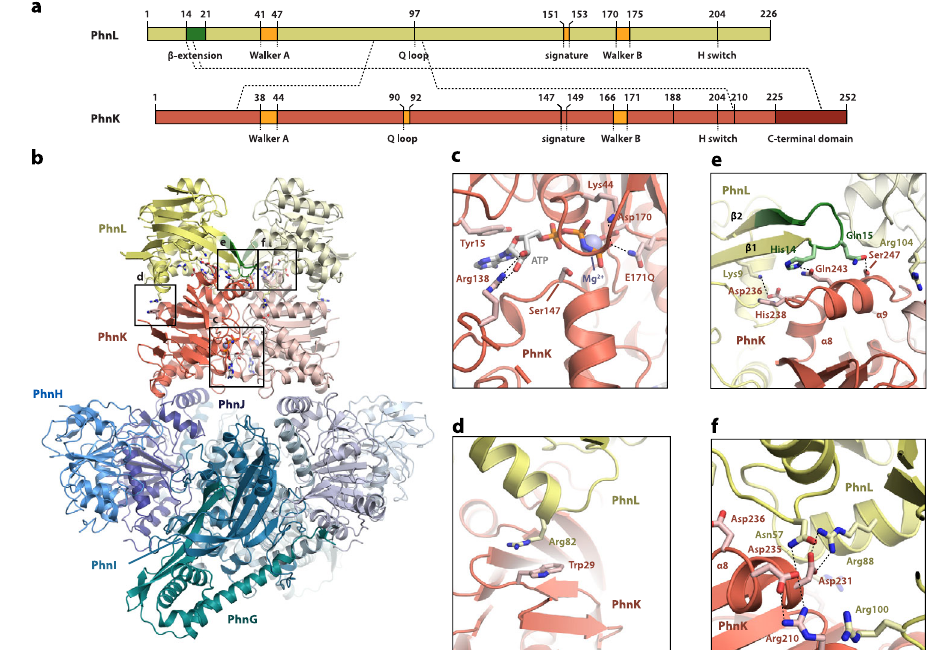
Fig.2|PhnGHIJKLbindsadoubledimerofPhnKandPhnL.a Top,anoverviewof the domain structure and sequences features of PhnL (top, yellow) and PhnK (bottom, red) with residue numbers indicated. The core ATPase motifs (Walker A and B,Q loop,signaturemotif,and H switch) are indicated inorange,the β hairpin extension of PhnL (residues 7 – 14) is shown in green and the C-terminal domain of PhnK is shown in dark red. Interactions between the proteins are shown with dashed lines. b An overview of the structure of PhnGHIJKL with the C-P lyase core complex PhnGHIJ in shades of blue/green and corresponding light colours for the